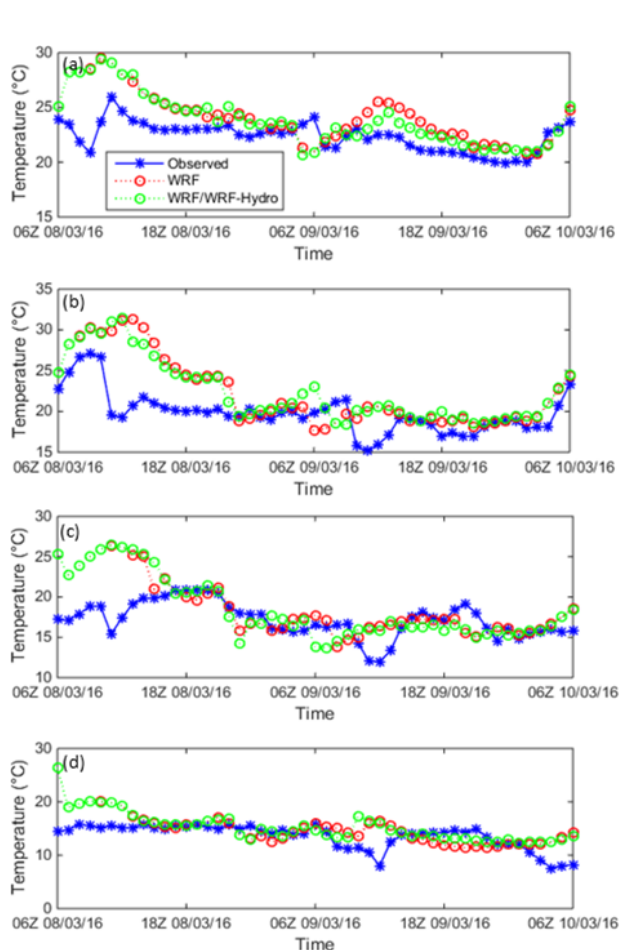
Figure 5. Comparison of 2m temperature observations at Abu Dhabi (a) , Al Ain (b) , Jabal Hafeet (c) , and Jabal Mebreh (d) sta- tions with WRF and WRF–WRF-Hydro simulations.